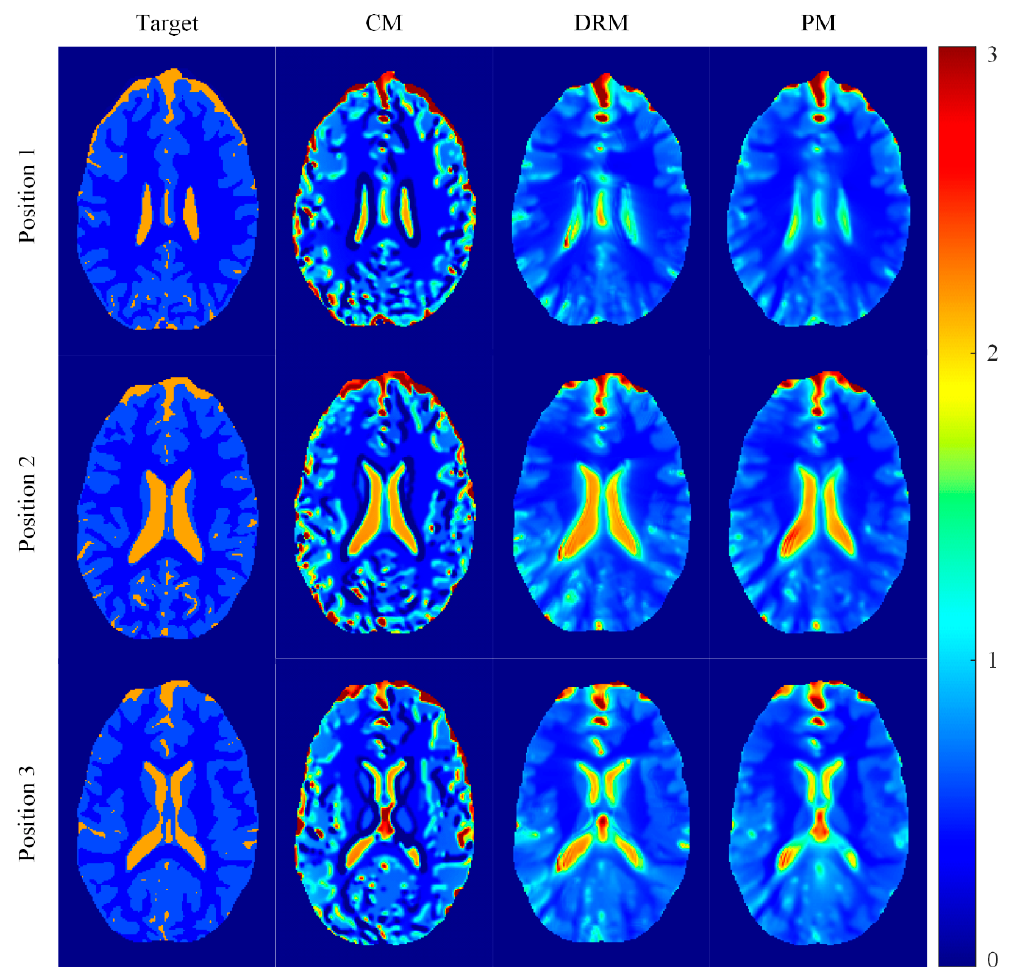
Figure 6. The reconstructed conductivity images of the Ella head model under noise-free conditions using the conventional method (CM), double regularization method (DRM), and proposed method (PM).